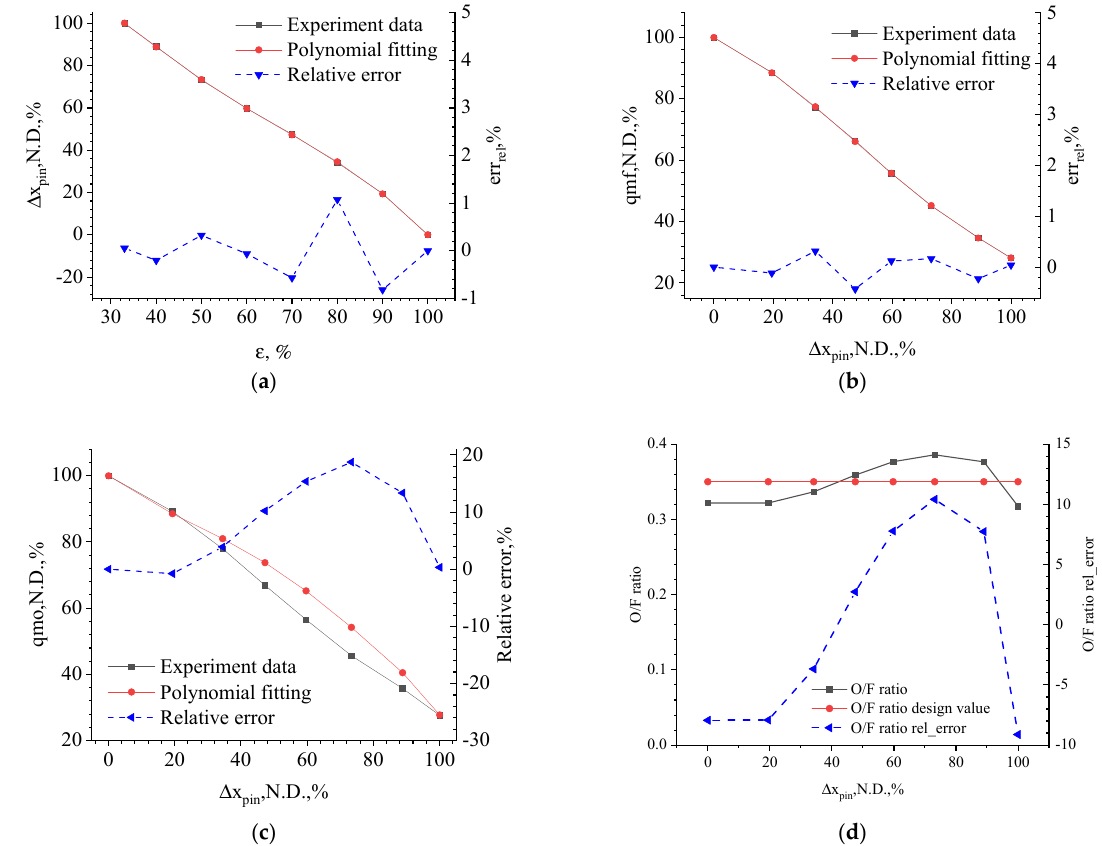
Figure 9. Experimental results of displacement–flow regulation characteristics of the IFRGG. ( a ) Work- ing condition factor-displacement. ( b ) Displacement-fuel flow. ( c ) Displacement-oxidizer flow. ( d ) O/F ratio and its